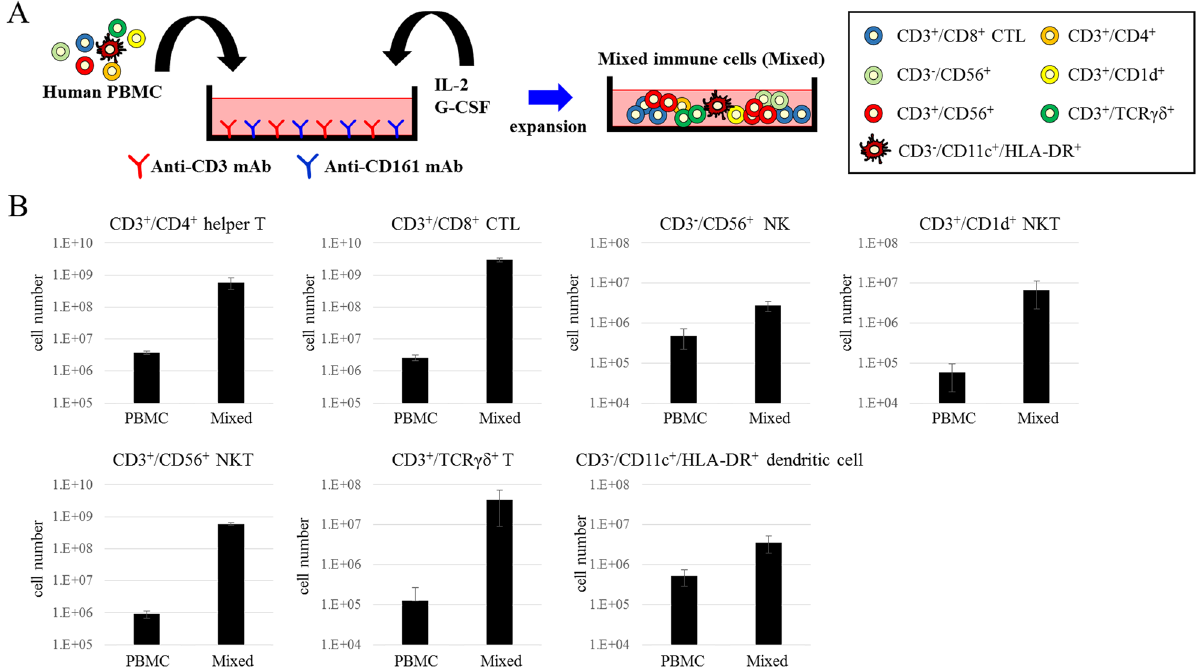
Figure 1. Novel culture method and expansion of immune cells. ( A ) Diagram of the novel culture method, consisting of CD3/CD161 co-stimulation with IL2 and G-CSF. ( B ) The numbers of CD3 + /CD4 + helper T cells, CD3 + /CD8 + CTLs, CD3 − /CD56 + NK cells, CD3 + /CD1d + NKT cells, CD3 + /CD56 + NKT cells, CD3 + / TCRγδ + T cells, and CD3 − /CD11c + /HLA-DR + dendritic cells before (PBMCs) and after (Mixed) expansion. The experiment was performed using PBMCs and cultured immune cells from three different donors. The data are shown as means ± SD.